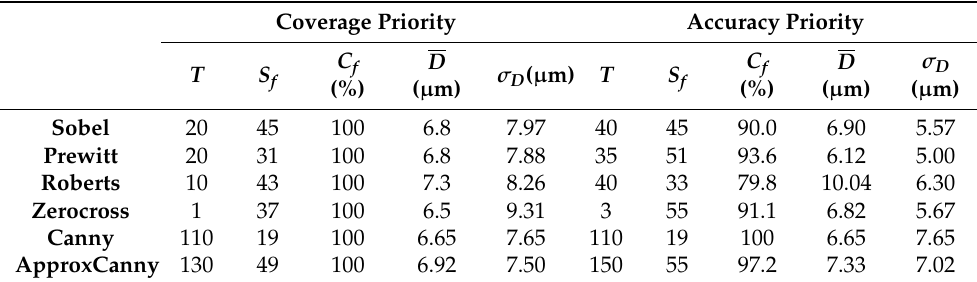
Table 3. Optimal combinations of test parameters for S